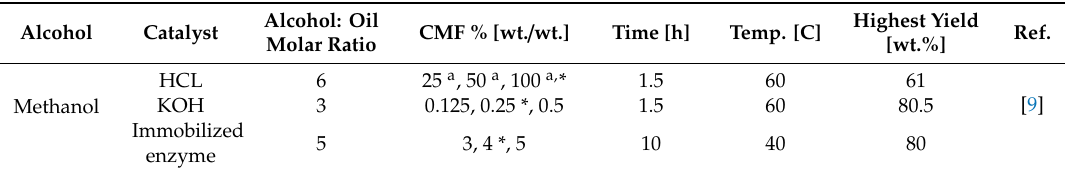
Table 2. Parameters and conditions for DSO transesterification determined by prior